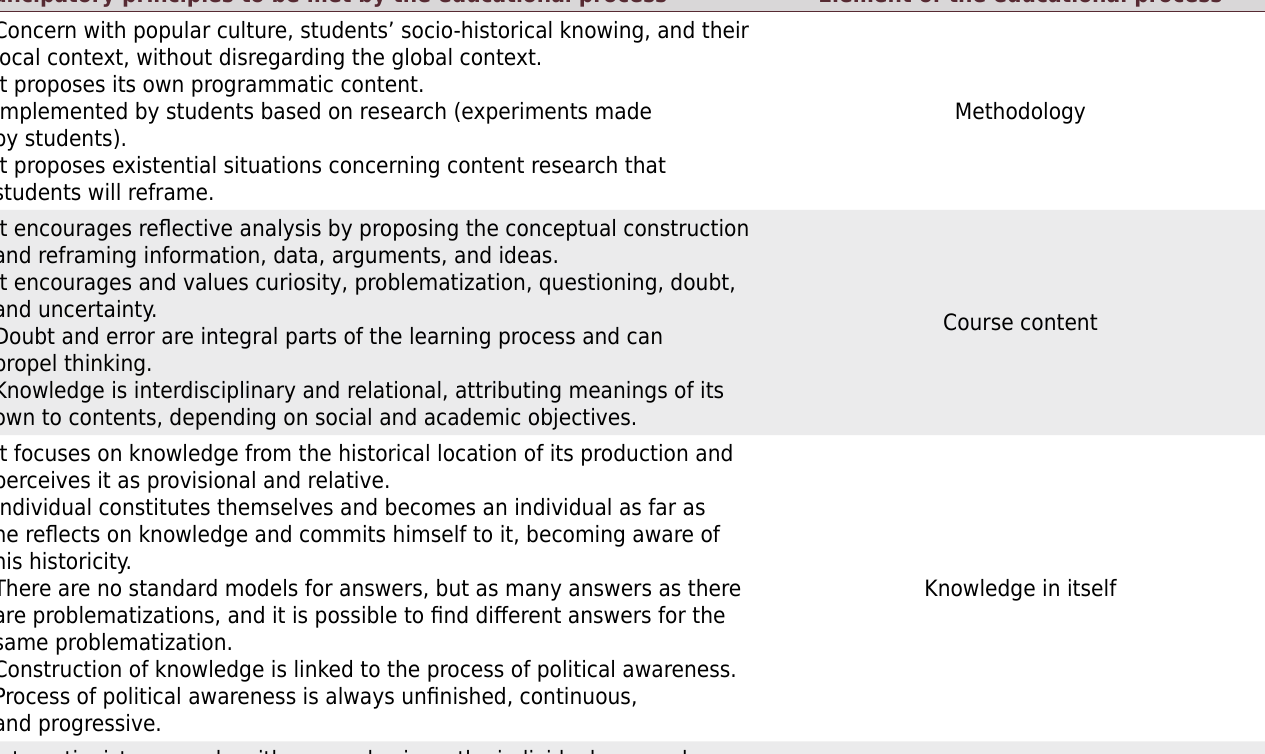
Table 1. Emancipatory principles that characterize the elements of an educational procedure, proposed based on Cunha (1998) and Mizukami (1983) Emancipatory principles to be met by the educational